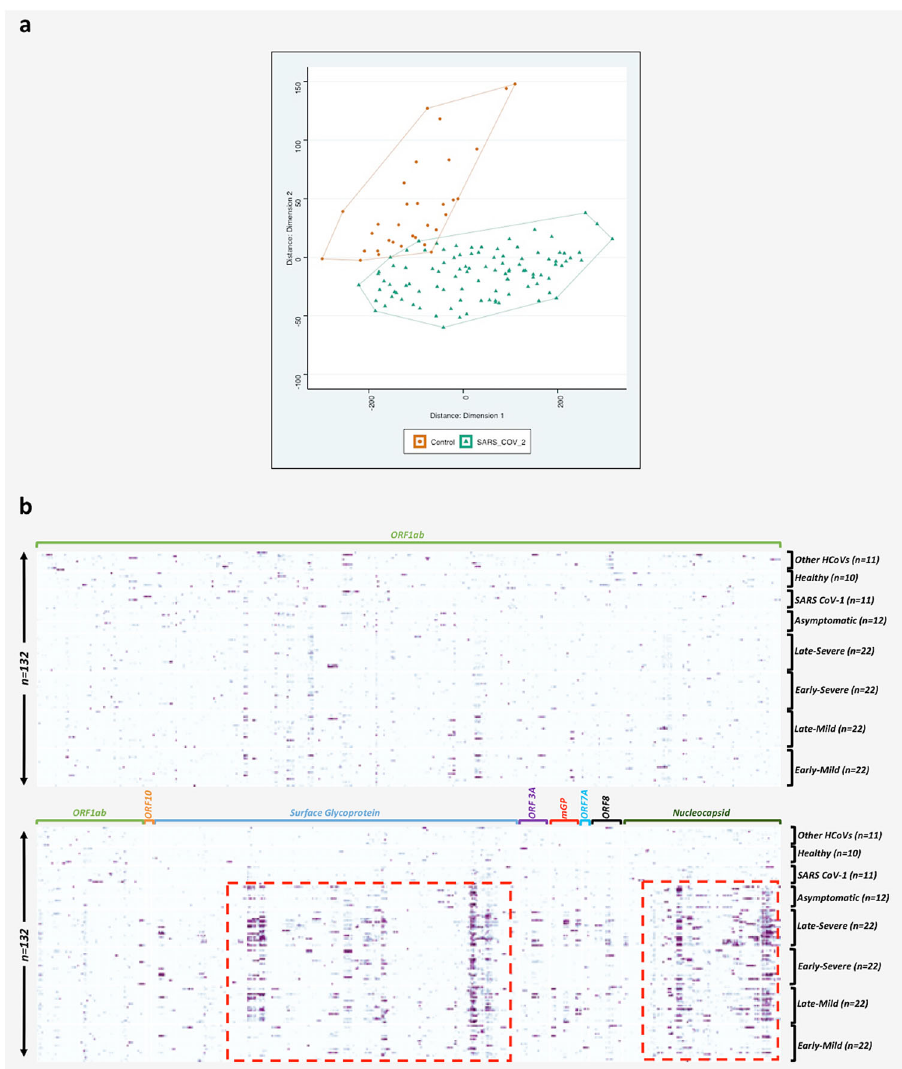
Fig. 1 Multidimensional scaling (MDS) of differential IgG peptide signals and heatmap showing differential peptide signals throughout SARS-CoV-2 proteome. a Multidimensional scaling (MDS) of differential IgG peptide signals in assays of sera from subjects with a history of infection with SARS-CoV-2 ( n = 100) or without historical exposure to SARS-CoV-2 (controls) ( n = 32). Based on MDS analysis, samples with exposure of SARS-CoV-2 samples (green) versus controls (red) clustered into two separate groups. b Proteome-wide linear epitope mapping of SARS-CoV-2-speci fi c IgG antibodies by a HCoV peptide array. X axis represents 981 peptides from SARS-CoV-2 proteins, Y axis represents 132 samples tested using the HCoV peptide array. Heatmap is plotted with normalized values of individual peptide intensity in AU for each of the 132 plasma samples. Panel grids show highly reactive areas in S and N proteins. *ORF1ab protein is large so divided partly in lower panel owing to larger fi rst time point. All 22 (100%) were reactive with at least 3 of 29 epitopes at the second time point. Plasma from 21 of 22 patients